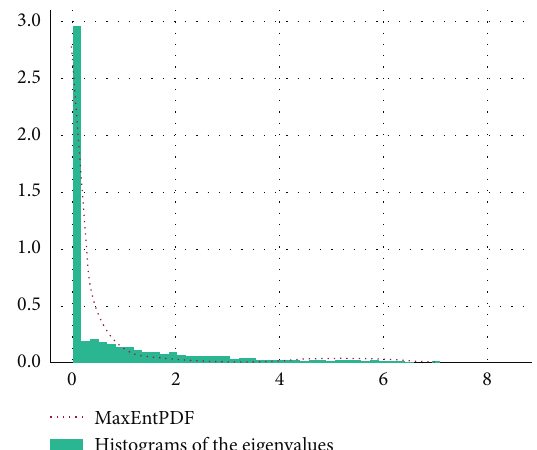
Figure 2: d � 200, n � 200, alpha � 0.5, and beta � 0.3.